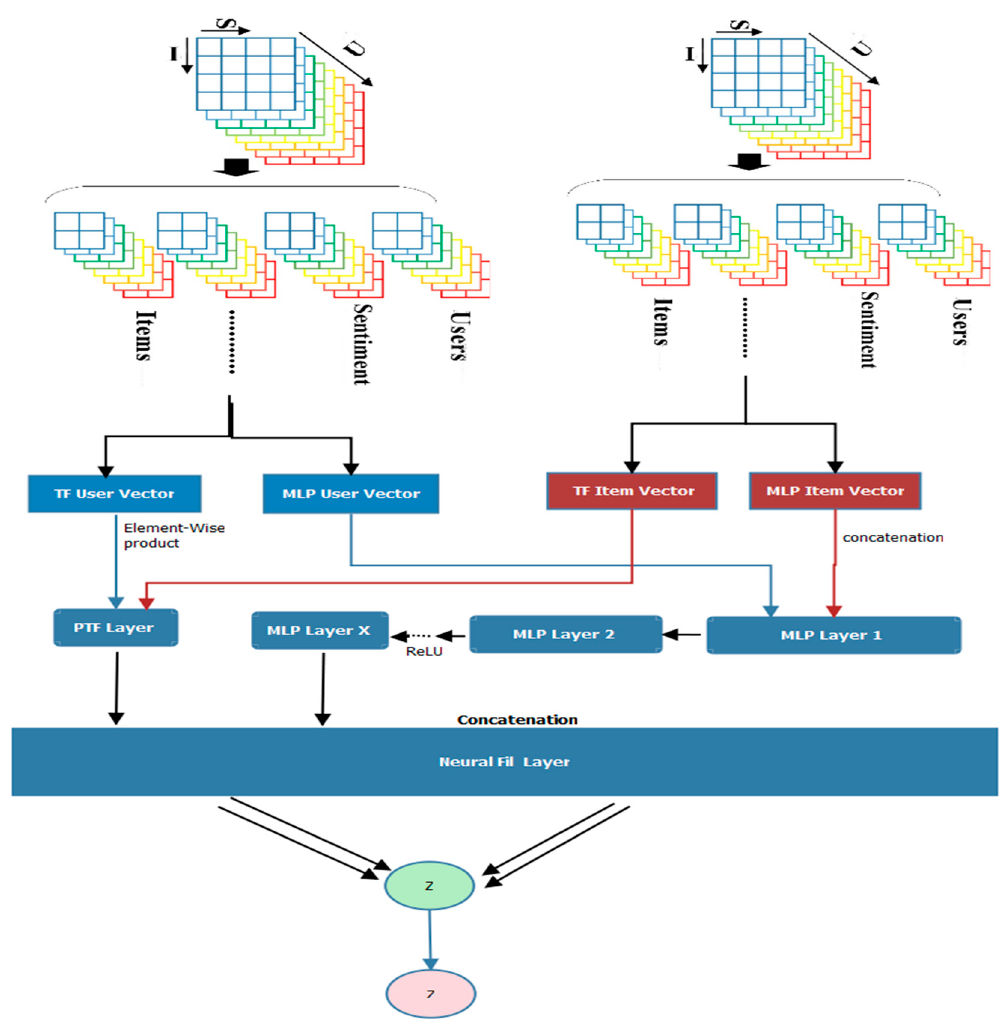
Figure 1. General Framework.